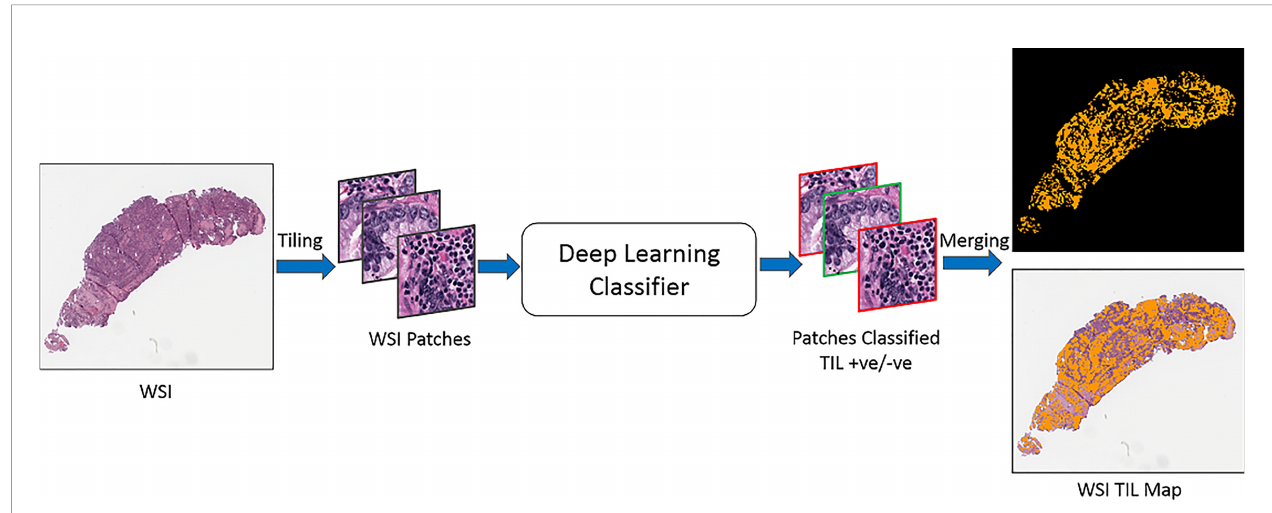
FIGURE 3 | TIL inference step. An input WSI is partitioned into disjoint patches of 50x50 square microns. Each patch is processed by the trained classi fi cation model and assigned a probability value. The probability values are mapped to binary classi fi cations. A TIL map covering the entire WSI is